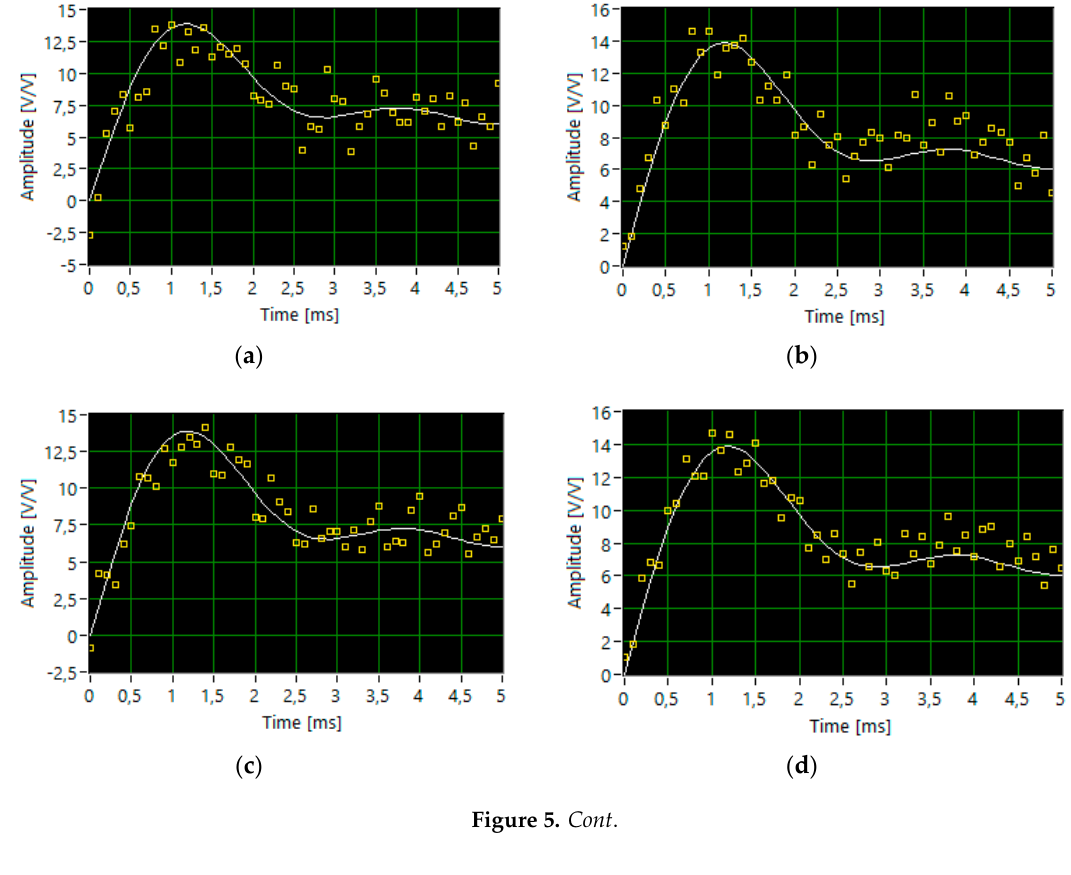
Figure 4. The results of simulation for set 1: ( a ) the segment of time waveform; ( b ) discrete Fourier transform (DFT) components of input signal.